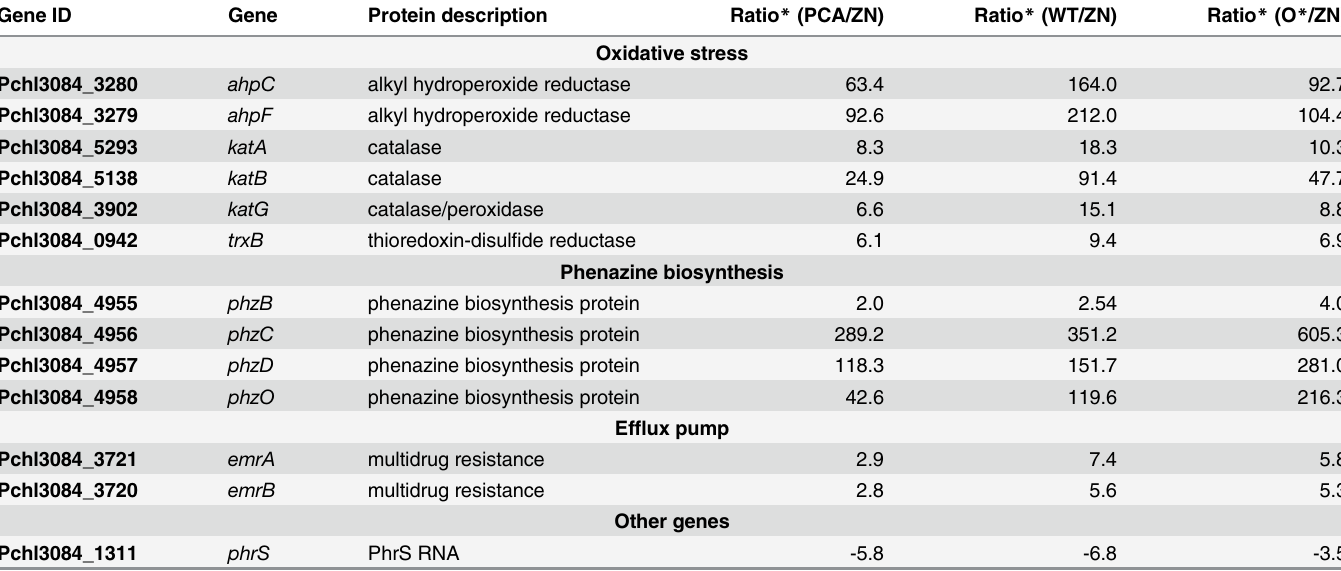
Table 2. Selected genes that are differentially expressed by all phenazine producers: e.g. by 30-84PCA, wild type, and 30-84O * compared with 30- 84ZN. Gene ID Gene Protein